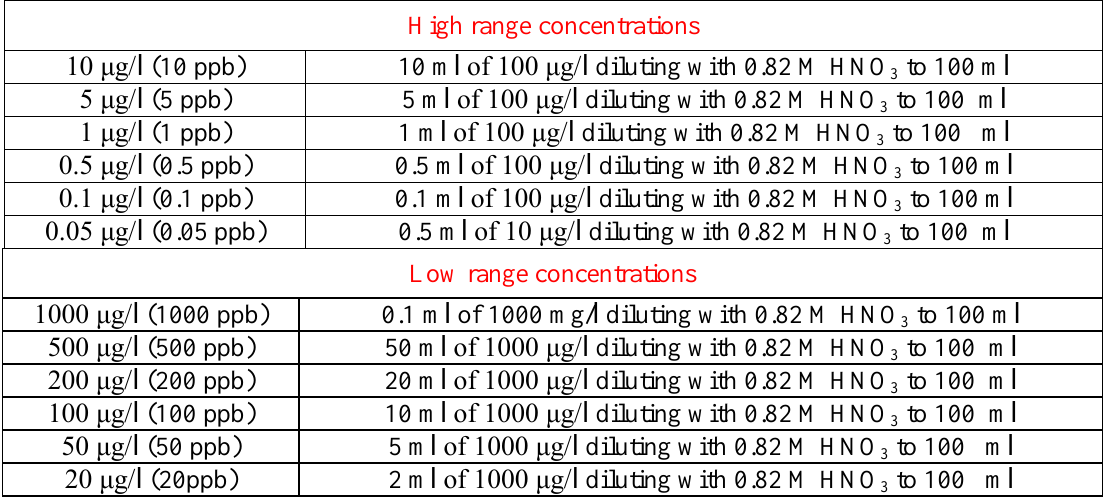
Table 3: Procedure of preparing uranium standard solutions [11]